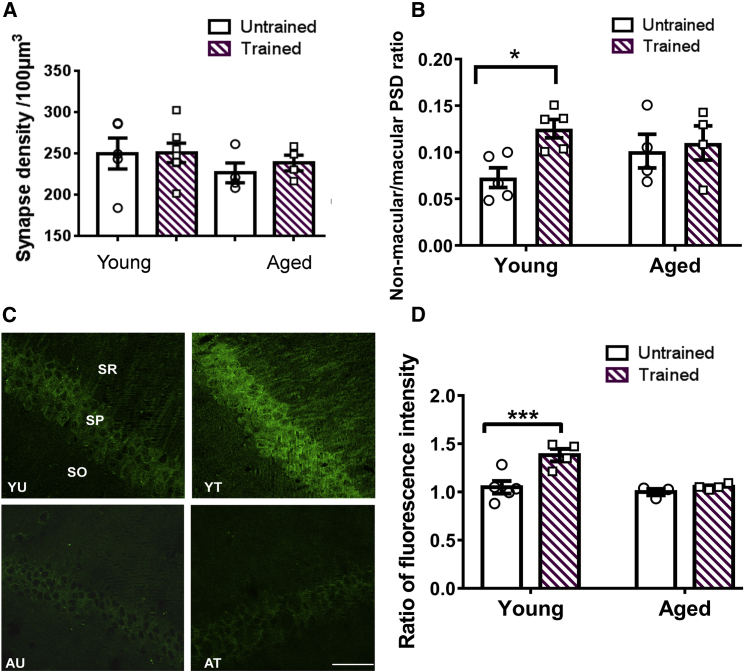
In Young but Not Aged Mice, Contextual Fear Memory Formation Is Associated with Ultrastructural and Molecular Alterations Characteristic for LTP(A) In young and aged mice, excitatory synapse density did not change 24 h after CFC as assessed by EM analysis (nYU = 5, nYT = 7, nAU = 4, nAT = 4; effect of age, F(1,16) = 1.55, p = 0.23; effect of CFC, F(1,16) = 0.21, p = 0.65; interaction CFC x age, F(1,16) = 0.16, p = 0.70).(B) In young but not aged mice, contextual fear memory formation was associated with an increase in non-macular, complex PSDs at the expense of macular PSD (nYU = 5, nYT = 5, nAU = 4, nAT = 4; ratio non-macular to macular PSDs: effect of age, F(1,14) = 0.22, p = 0.65; effect of training, F(1,14) = 4.80, p < 0.05; interaction CFC x age, F(1,14) = 2.44, p = 0.14; Tukey’s post hoc tests, YU versus YT, p < 0.05; AU versus AT, p = 0.68).(C) Representative images of T286-autophosphorylated αCaMKII in dorsal CA1 stratum radiatum (SR), stratum pyramidale (SP), and stratum oriens (SO) in young and aged mice before and 2 h after CFC. The fluorescence intensity in SR was referred to fluorescence intensity in SO (see STAR Methods). The scale bar represents 20 μm.(D) Quantification of the immunohistochemistry showed that contextual fear memory formation induces T286-autophosphorylation in young but not in aged mice (nYU = 5, nYT = 4, nAU = 3, nAT = 4; effect of age, F(1,12) = 11.3, p = 0.06; effect of CFC, F(1,12) = 12.02, p < 0.01; interaction CFC x age, F(1,12) = 6.13, p < 0.05; Tukey’s post hoc tests: YU versus YT, p < 0.001; AU versus AT, p = 0.52).Mean ± SEM, ∗∗∗p < 0.001, ∗p < 0.05. Individual data plots representing each animal within the group overlay the bar graphs. See also Figures S1–S4.